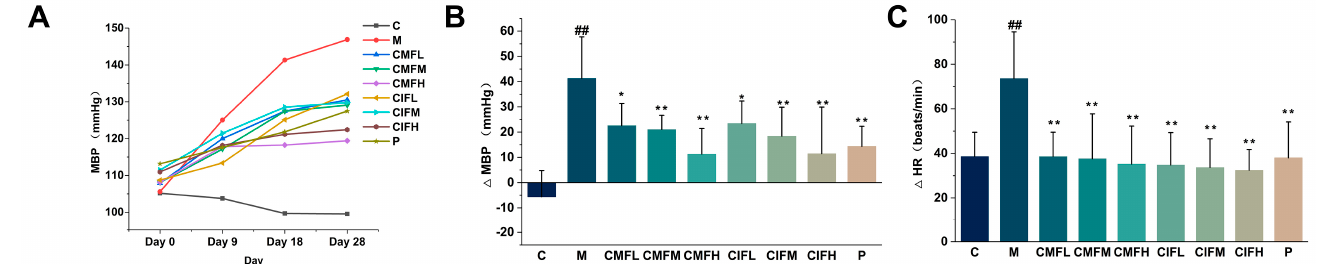
Figure 3. The competence of CMF and CIF in lowering blood pressure and HR. ( A )—The change of MBP under four measurements; ( B )—Difference value between the last and the first measurement of MBP; ( C )—Difference value between the last and the first measurement of HR. Values shown are mean ± SD. ## p < 0.01 compared with C group; * p < 0.05, ** p < 0.01 compared with M group.